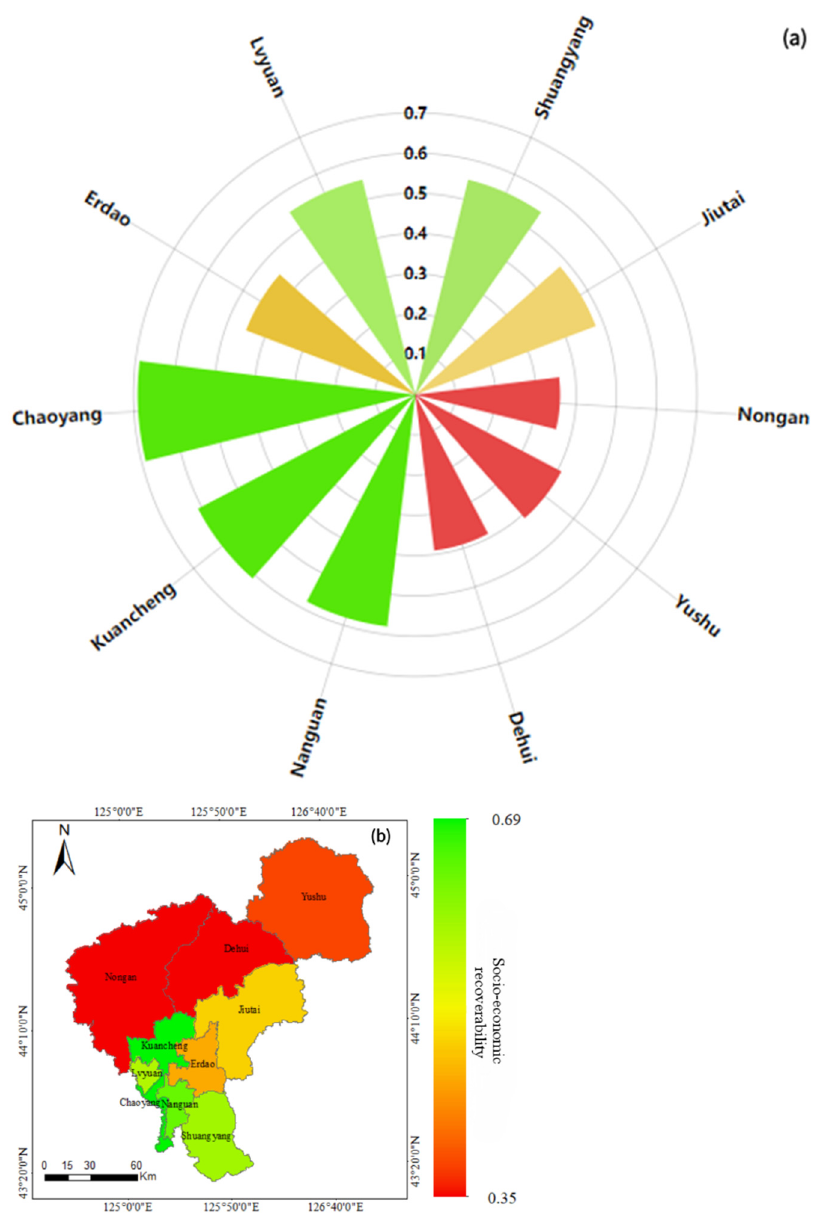
Figure 5. Socioeconomic recoverability map: recoverable value ( a ); spatial distribution of recoverability ( b ).